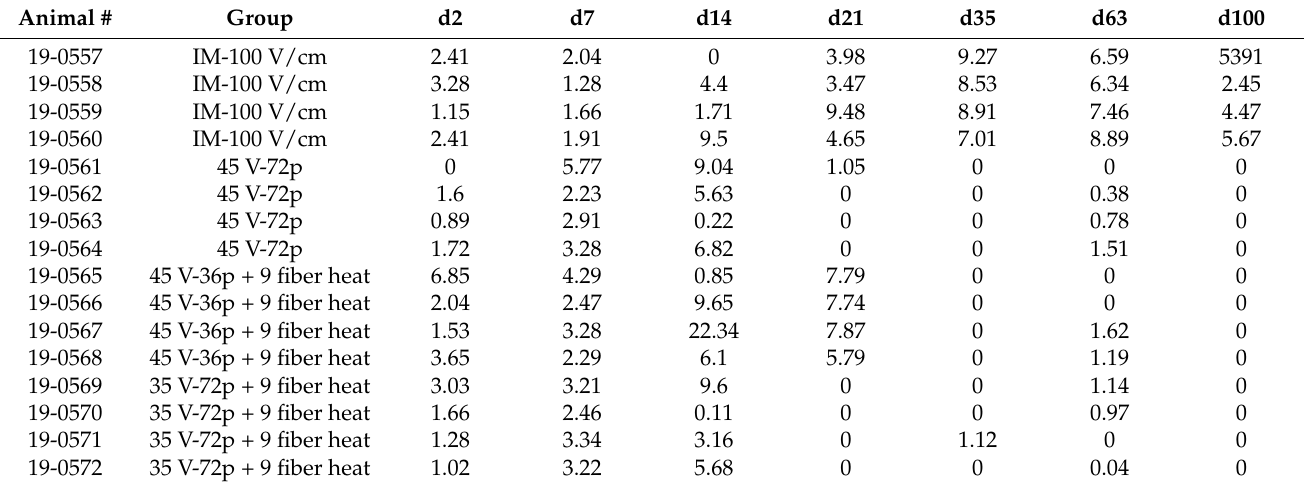
Table A1. Raw data used for Figure 8.